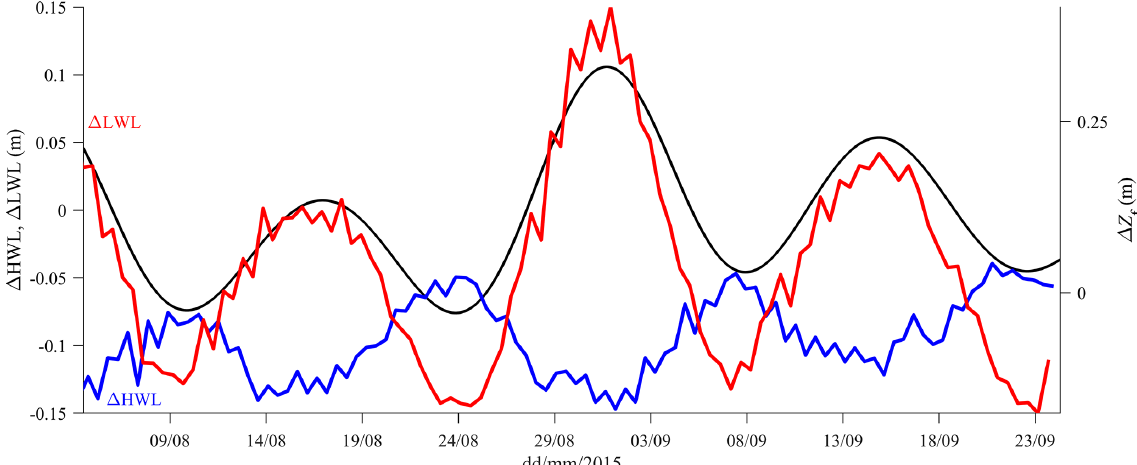
Figure 5. Differences in the relative water level between St3 and St0, showing the fortnightly tide ( (cid:49)Z f ; black line; right axis), (cid:49) HWL (blue line; left axis), and (cid:49) LWL (red line; left axis).